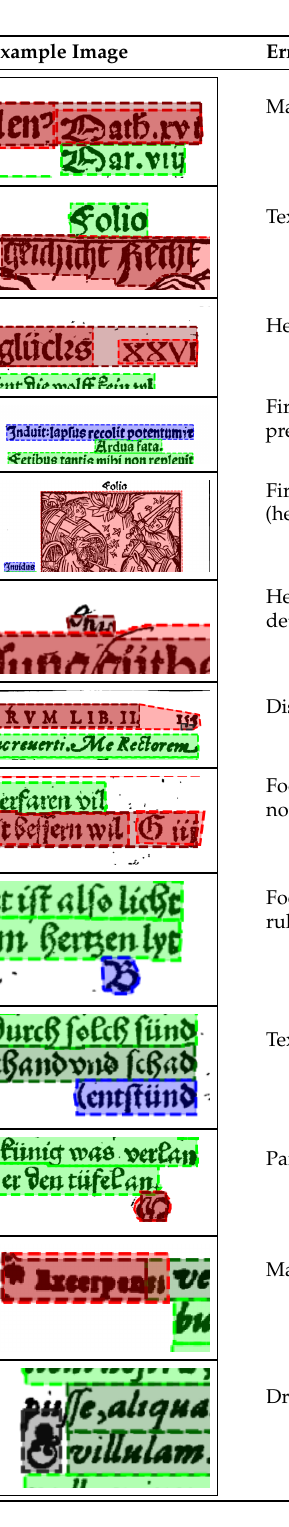
Table 5. Manual error analysis of commonly occurring errors in the individual datasets. Errors were counted per occurrence even if multiple polygons were affected. Columns labeled (m) are results with manually adjusted settings. In the example images, incorrect lines are colored red (bright red is the GT polygon, brown the predicted polygon), detected, but misclassified lines are colored blue (prediction is shown), and detected and correctly classified lines are colored green. Grey lines are false positives with no GT